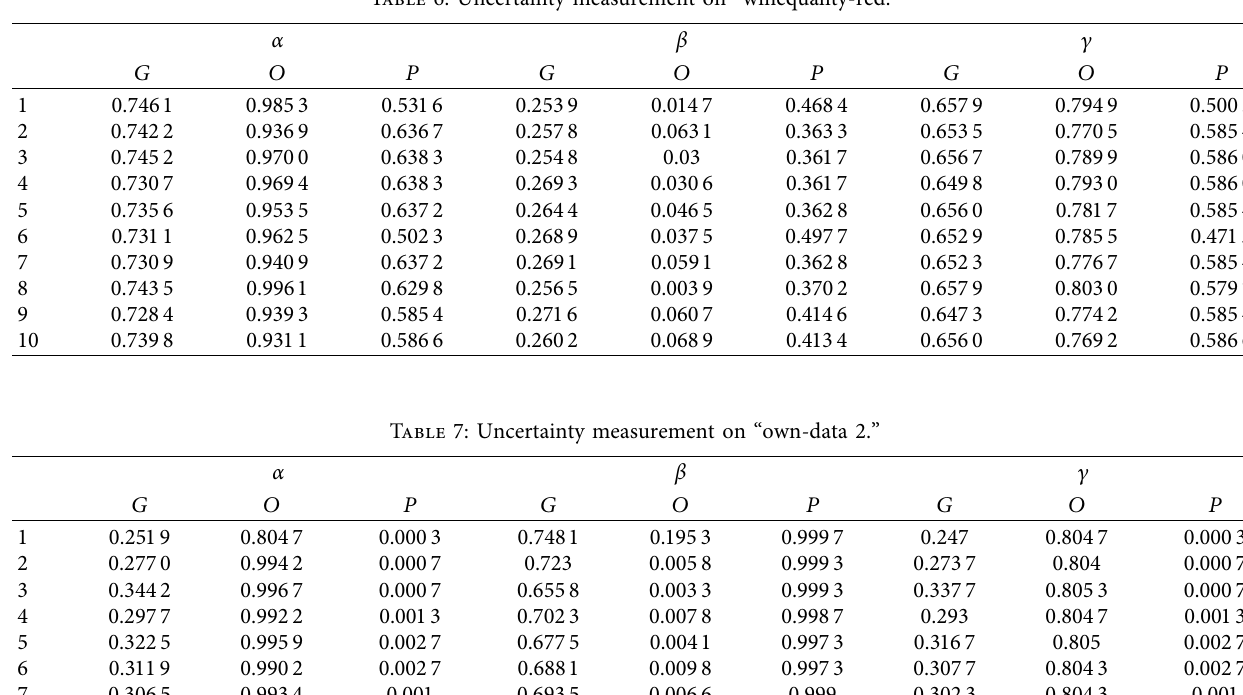
Table 6: Uncertainty measurement on “winequality-red.”